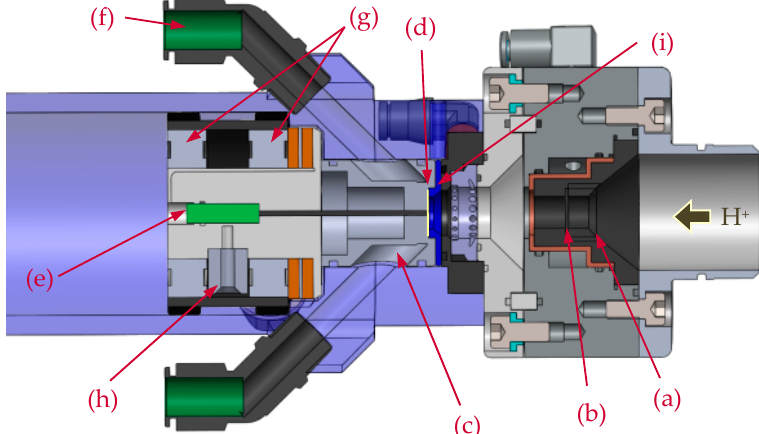
Figure 1. Schematic of cast alloy solid target: (a) 10 mm graphite collimator with removable crown; (b) graphite degrader; (c) 3D-printed A357 target holder; (d) target material; (e) type-K thermocouple; (f) 8 mm ID water line; (g) ceramic bearings; (h) lead ballast; (i) magnetically coupled Nb front cover.